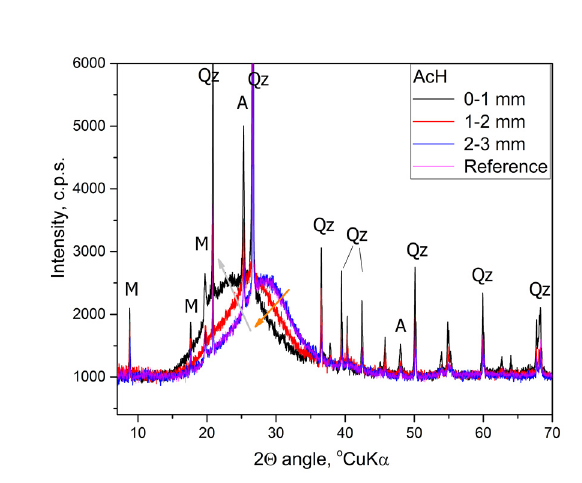
Figure 13. X ‐ ray powder diffraction of sliced cross sections. Notation for identified crystalline phases: M ‐ muscovite, A ‐ Anatase, Qz ‐